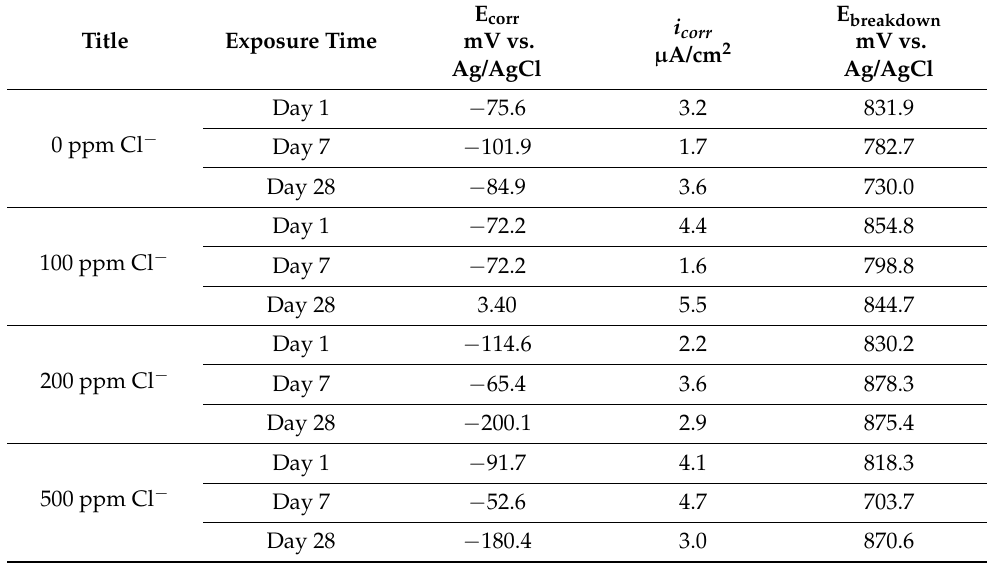
Figure 2. Polarization plots of cast iron in ( a ) 0 ppm, ( b ) 100 ppm, ( c ) 200 ppm, and ( d ) 500 ppm chloride containing coolants and different exposure times. Non-constant immersion sample scan (day 0 sample) was performed after ~30 min of exposure to respective chloride concentration. Table 3. Summary of polarization results on cast iron samples in engine coolant environment.